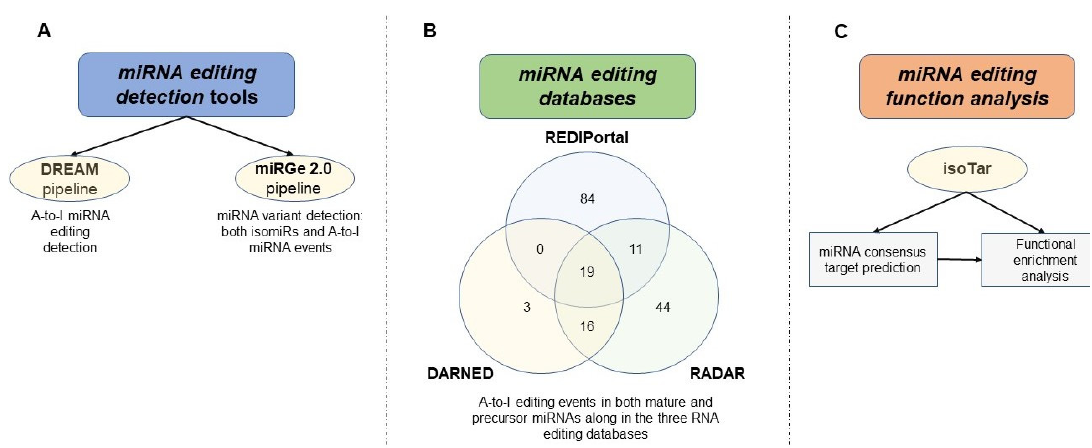
Figure 2. Methods for MicroRNA Editing Detection and Functional Characterization. ( A ) Two principal and most used pipeline (DREAM and miRGe 2.0) for miRNA editing detection. ( B ) Distribution of 177 putative and / or validated A-to-I RNA editing events in both mature and precursor miRNA molecules along with the three major RNA editing databases (DARNED, RADAR, and REDIPortal). ( C ) Illustration of isoTar, a web-based containerized tool designed consensus targeting prediction and functional enrichment analyses for miRNAs harboring editing sites and